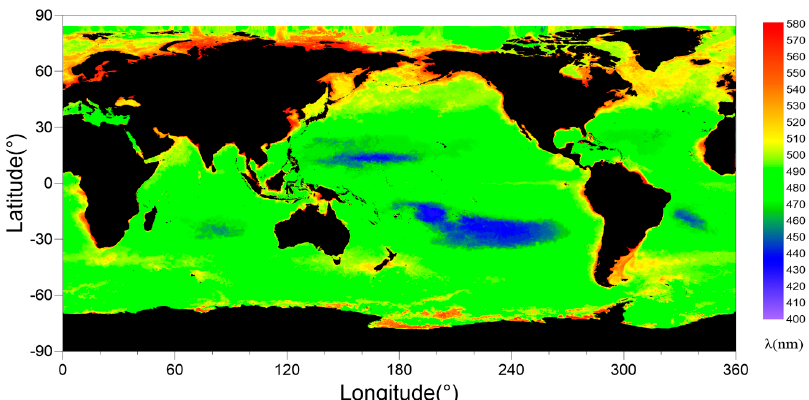
Figure 3. Spatial distribution of the optimal wavelengths at the global scale.